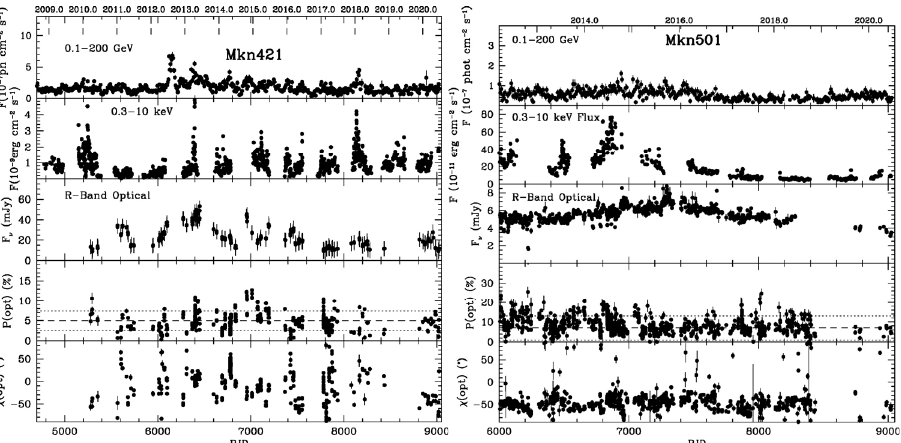
Figure 3. Multi-wavelength light curves and optical linear polarization vs. time for the two HSP blazars Mkn421 and Mkn501. RJD is the Julian date minus 2,450,000. The contribution of starlight from the host galaxy has been subtracted. In the optical polarization panel (4th from the top), the dashed line is the mean degree of polarization, while the dotted lines indicate ±1 standard deviation from the mean. Updated from [2].